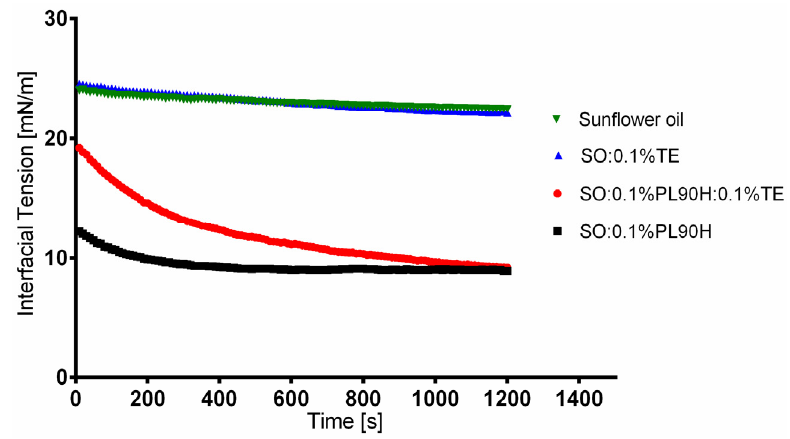
Figure 2. Dynamic interfacial tension curves of PL90H, TE, and PL90H + TE mixture dispersed in SO with water ( n = 10).